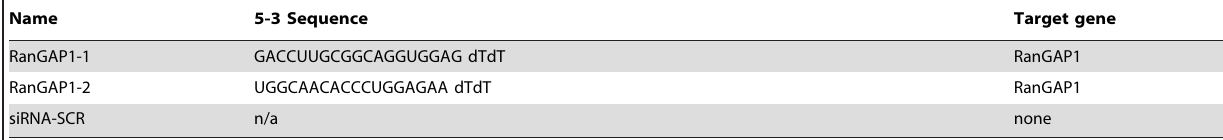
Table 1. siRNA Sequences.